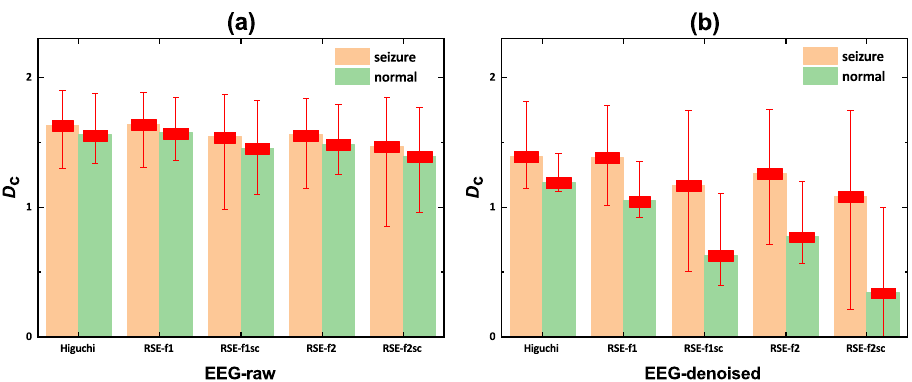
Figure 5. D c mean values based on Figure 3 for seizure and normal statuses calculated by ( a ) raw signals and ( b ) denoised signals using various algorithms. The red lines were represented the error bar, and red solid boxes on each column were represented the corresponding standard deviation.